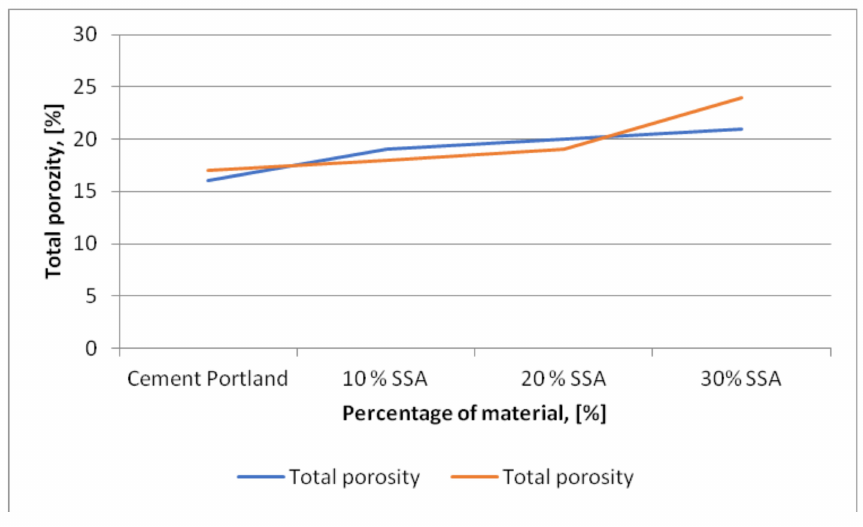
Figure 4. Total porosity [41,42]. Table 7. Total